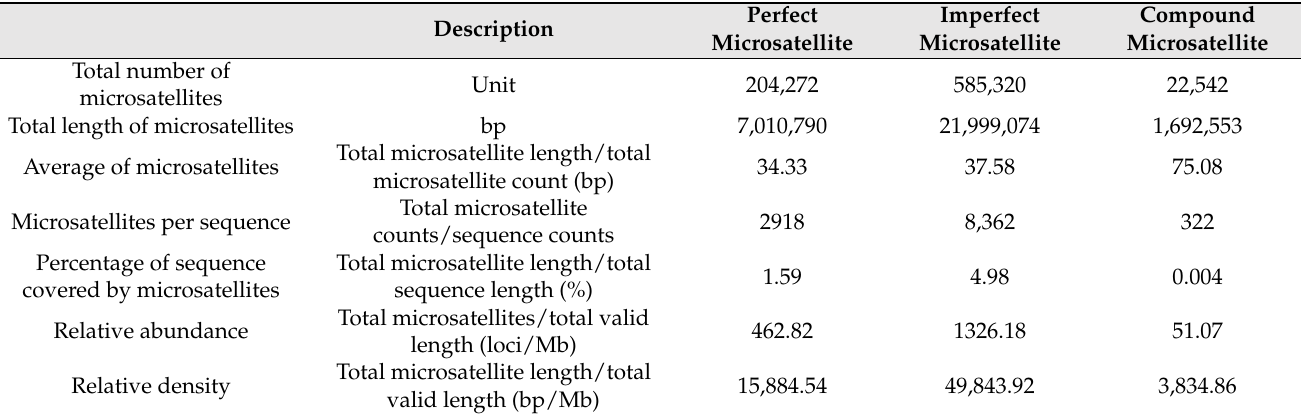
Table 3. Summary of perfect, imperfect, and compound microsatellites detected in the whole genome of Siamese fighting fish ( Betta splendens, Regan, 1910 [2] (accession no: GCA_900634795.3, 441